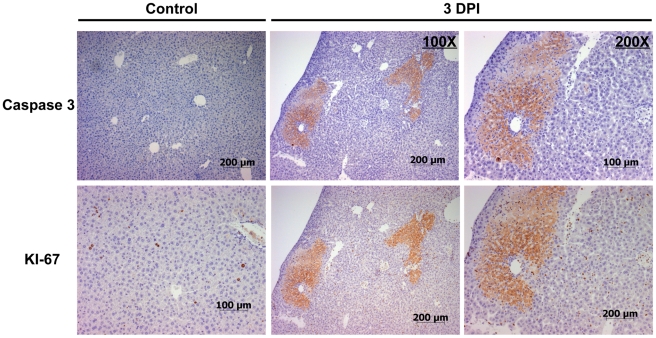
Activated caspase 3 and Ki-67 in C. rodentium-induced liver lesions.Control livers showed minimal staining for the apoptotic marker activated caspase 3, and proliferative marker Ki-67 (far left panels), while livers with necrosis at 3 DPI stained positively for both markers with a periportal pattern of distribution (middle (100×) and far right (200×)). Pictured is a representative liver section that was serially sectioned and immunostained independently for each cellular marker.